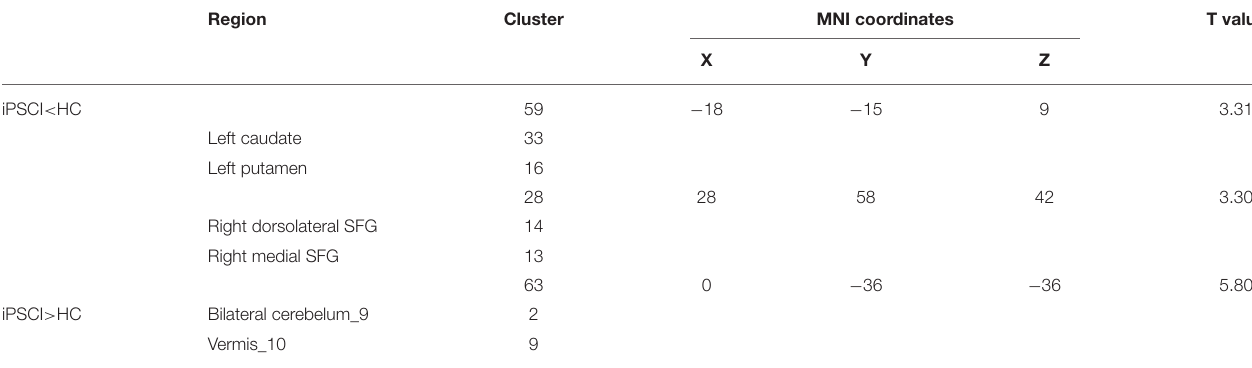
TABLE 3 | Comparisons of fALFF between cognitive impairment group after ischemic stroke (iPSCI group) and healthy control group (HC group). Region Cluster